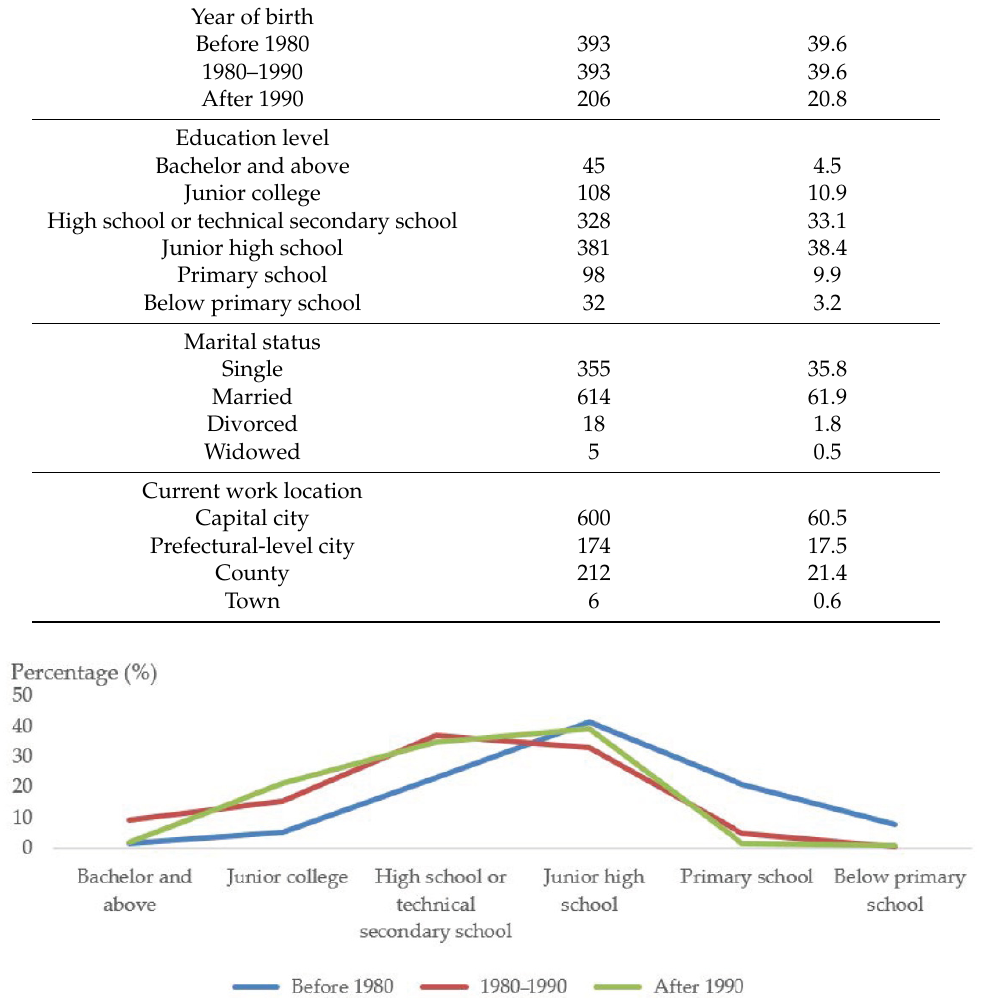
Figure 4. Educational levels of samples at different age levels. Table 1. Demographic information of questionnaire respondents.